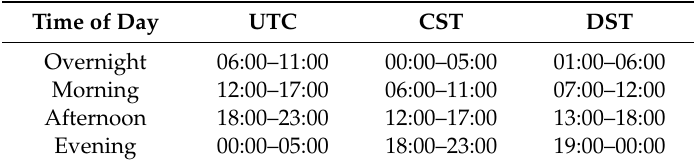
Table 2. Time intervals defined for four times of the day in Coordinated Universal Time (UTC), Central Standard Time (CST) and Daylight-Saving Time (DST).